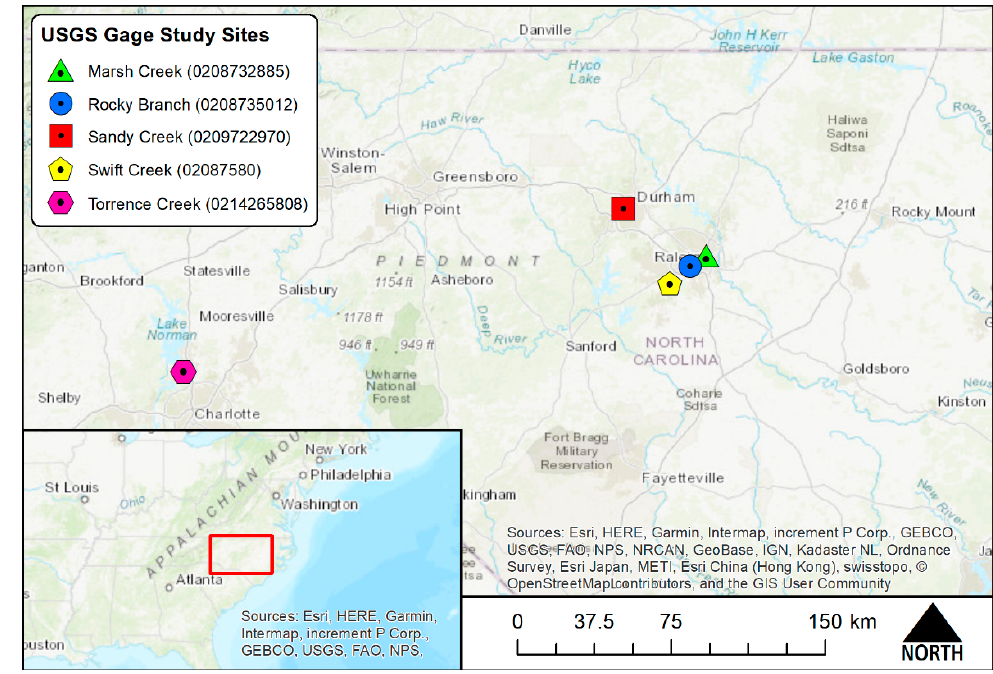
Figure 1. USGS gage study site locations.